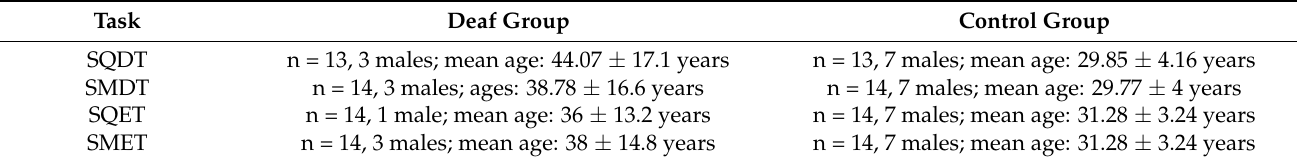
Table 1. Information about the sample size and average age of participants for each task for both deaf and control groups. SQDT = sequential discrimination task; SMDT = simultaneous discrimination task; SQET = sequential estimation task; SMET = simultaneous estimation task. Task Deaf Group Control